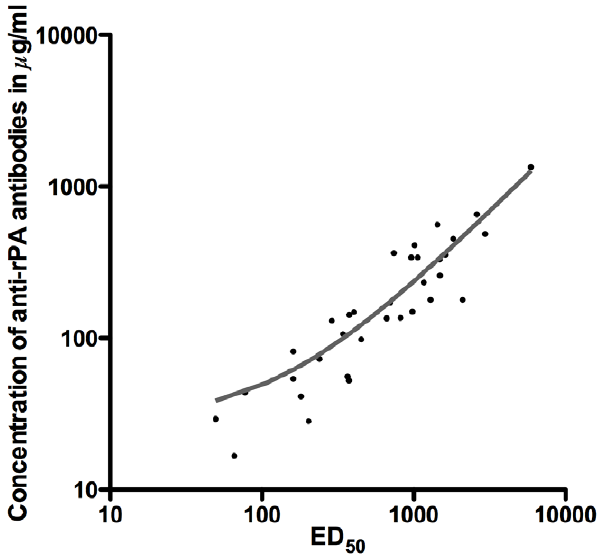
Figure 6. Correlation between the concentration of anti-rPA binding antibodies and the ED 50 for the individual samples. The plot depicts the relationship between the level of anti-rPA antibody binding and the neutralization ED 50 in the TNA. A linear regression (grey line) indicates a strong correlation between the two parameters (R 2 =0.86). All samples from rPA recipients are included in the linear regression calculation, however, only the data that were above the limit of quantitation for both assays are